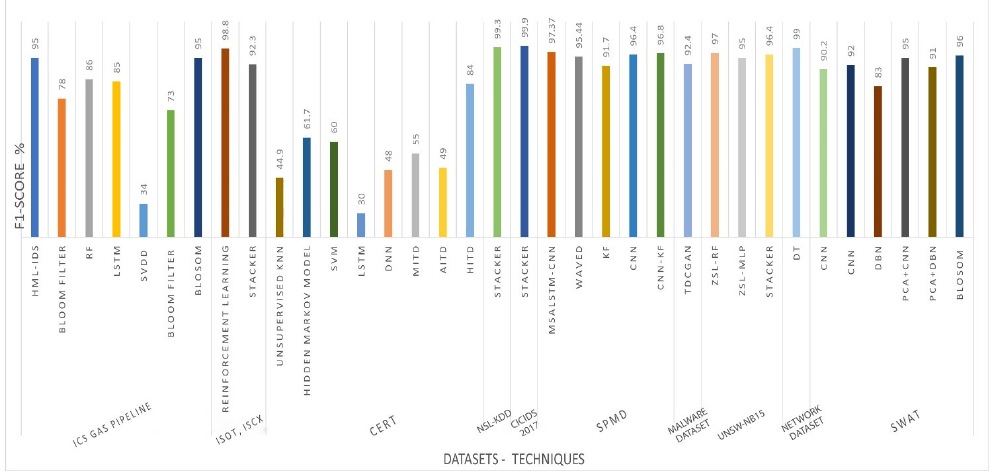
Figure 8. The F1-score of the compared techniques on different